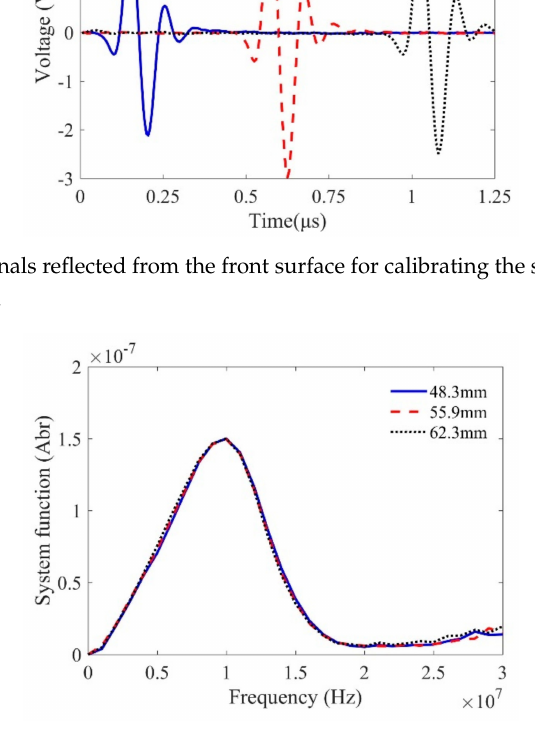
Figure 6. Calibrated system function using the above measured reference signals in Figure 5.